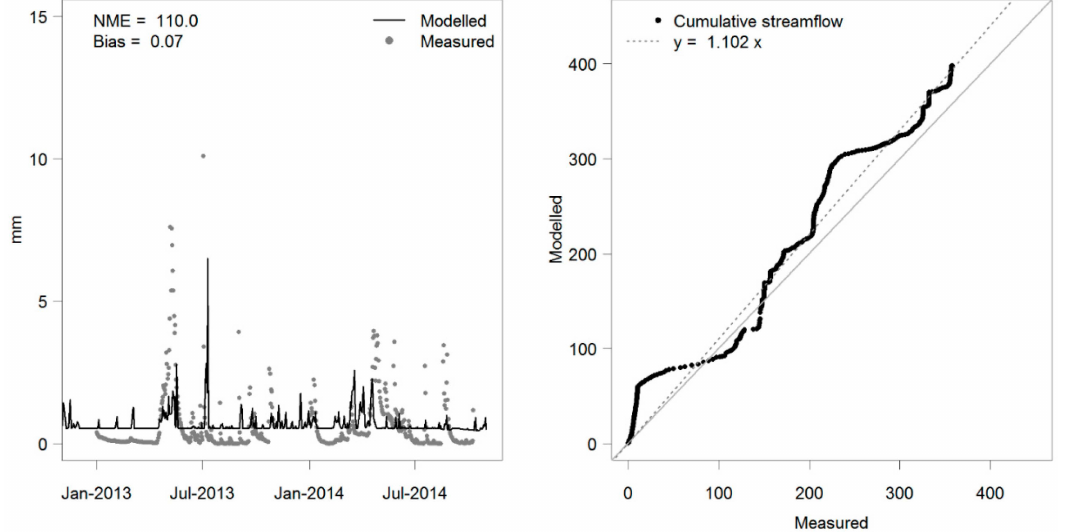
Figure 9. Modelled as compared to measured streamflow. Differences between model and measurements are evaluated in terms of NME (%) and Bias (mm). The graph on the right compares the cumulative streamflow in 2013-2014 when measurements were